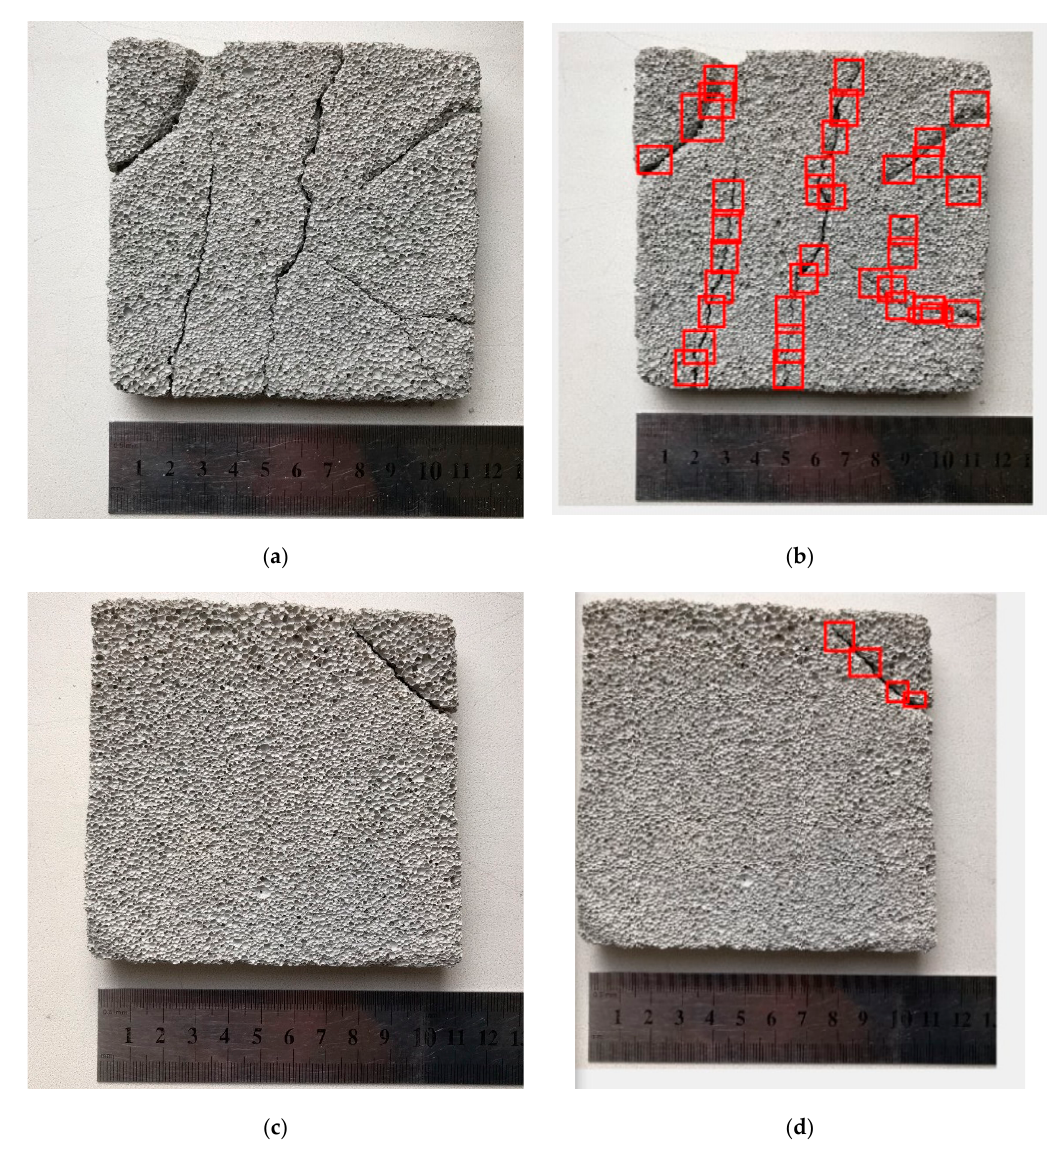
Figure 7. Results of the detector operation: ( a , c ) original image; ( b , d ) the result of the algorithm based on YOLOv4.